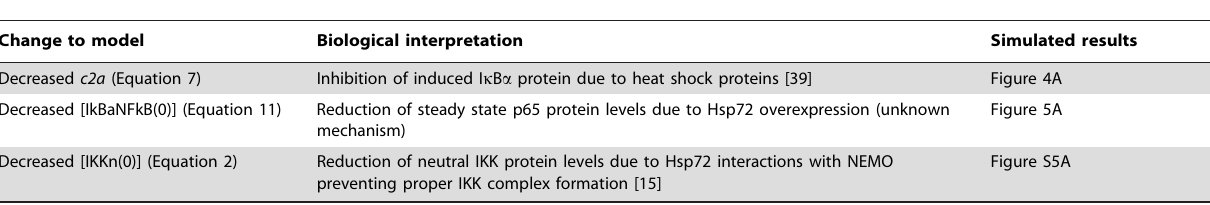
Table 2. Modified model parameters to simulate possible regulation of steady state protein levels in the NF- k B signaling network.